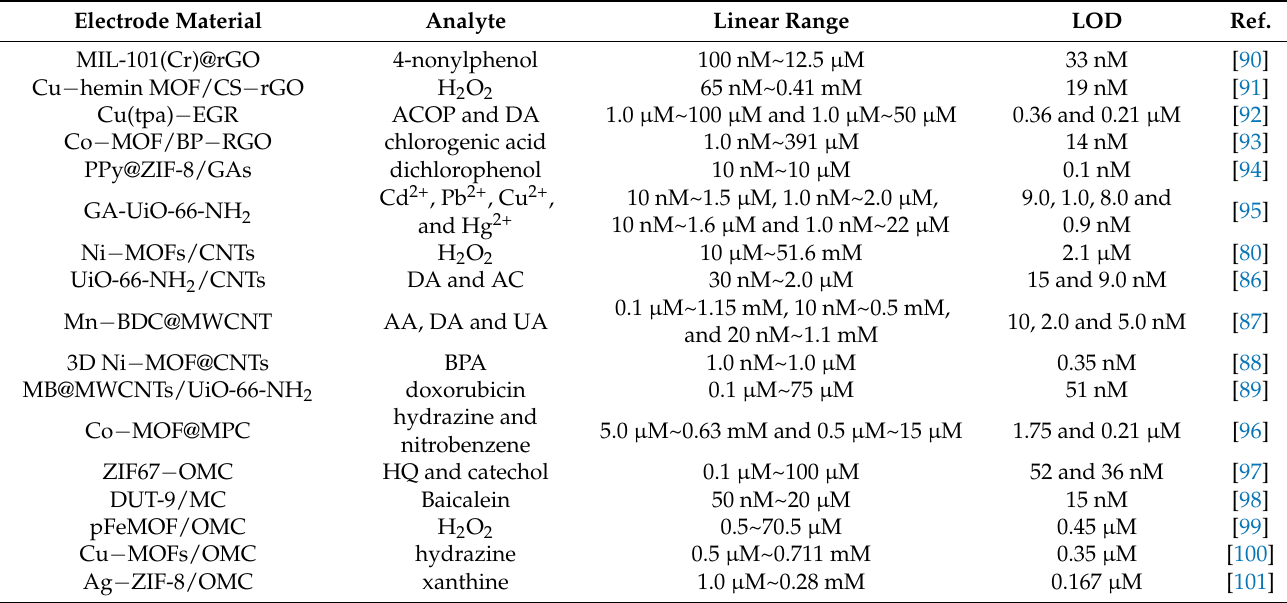
Table 2. The detection performances of carbon nanomaterials-decorated MOF − based electrochemical